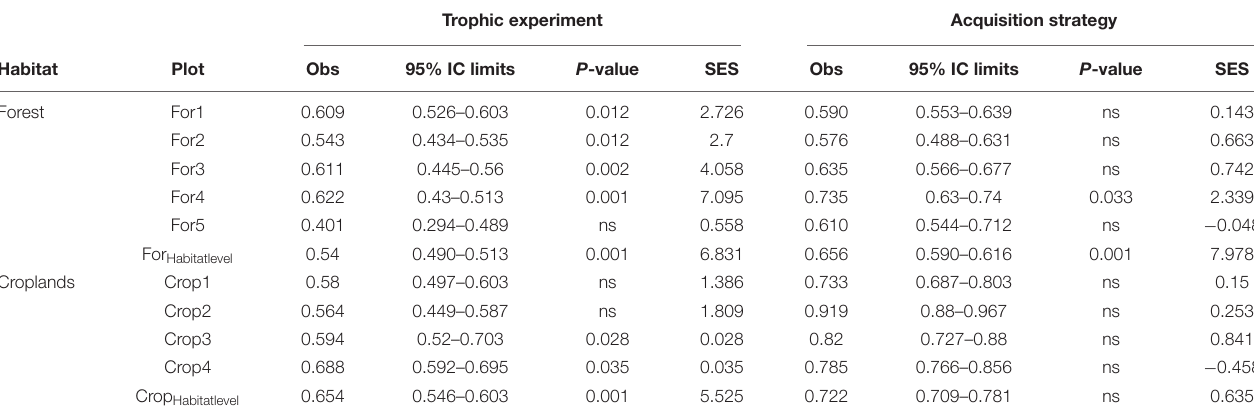
TABLE 5 | Observed and expected range of trophic niche overlap measured at assemblage and habitat